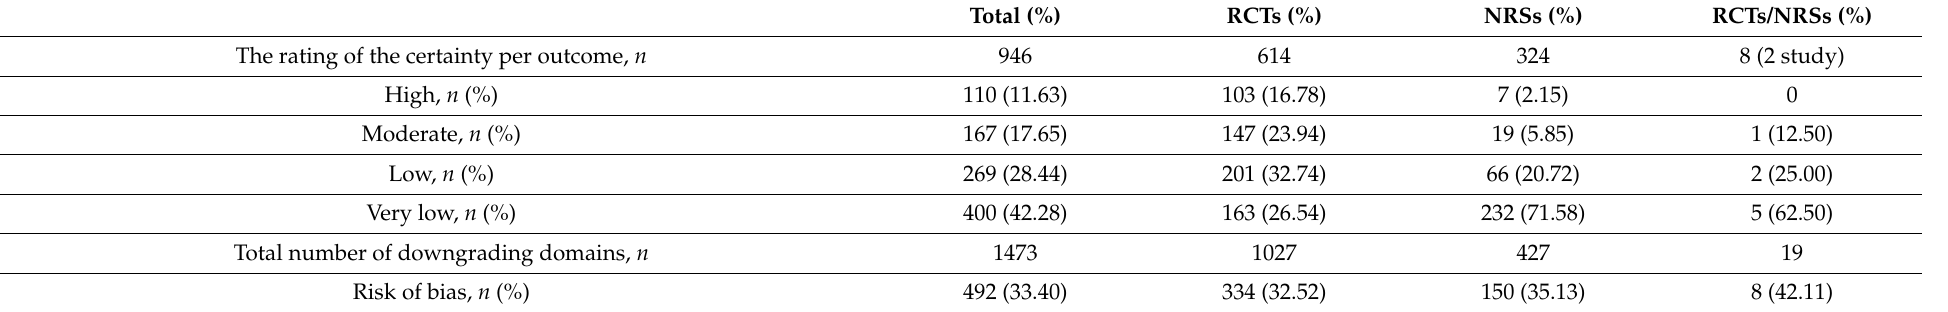
Table 6. Frequency of the rating domains according to study